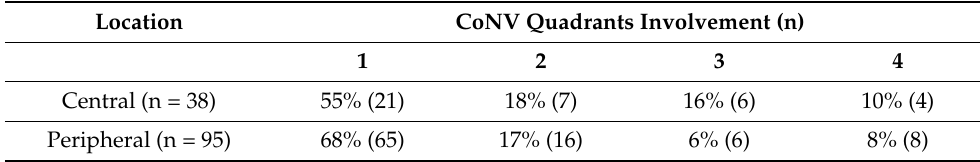
Table 2. Number of quadrants with CoNV for peripheral and central lesions.